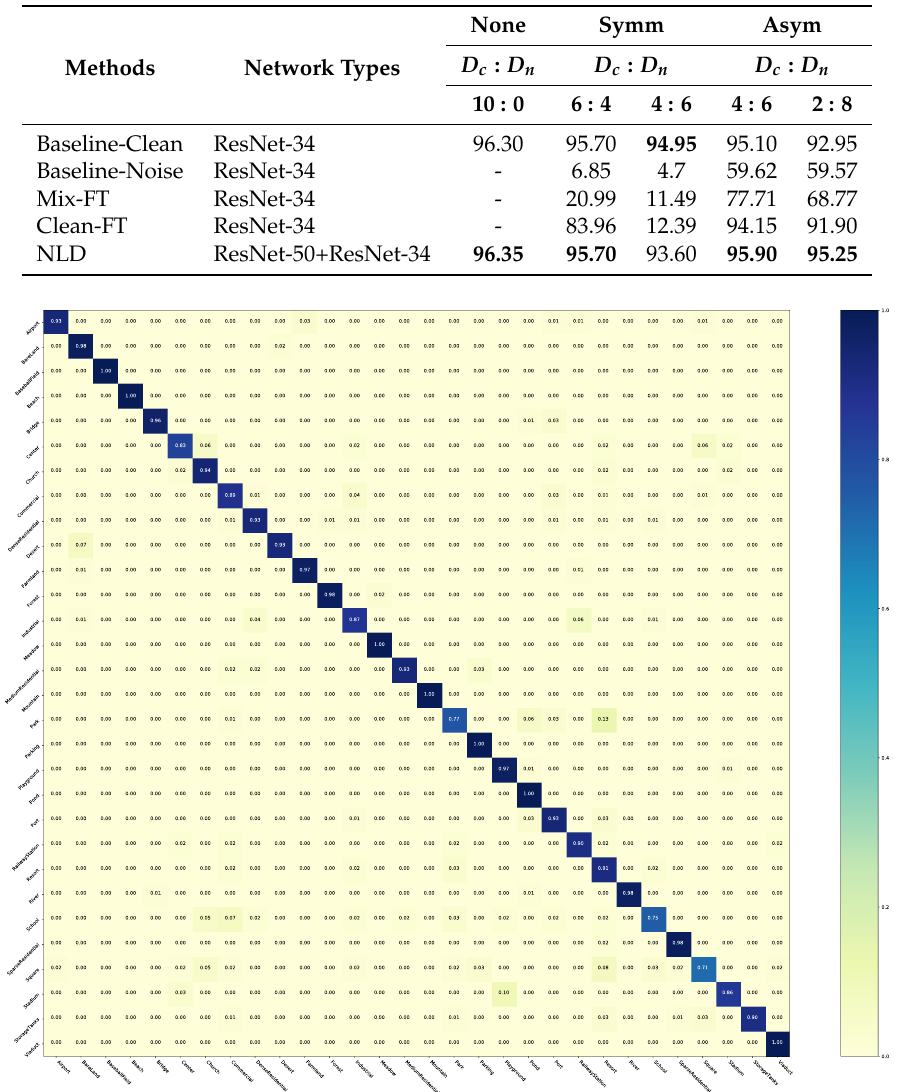
Figure 11. The confusion matrix of Baseline-Clean for the AID dataset with asymmetric noise of D c : D n = 2 :